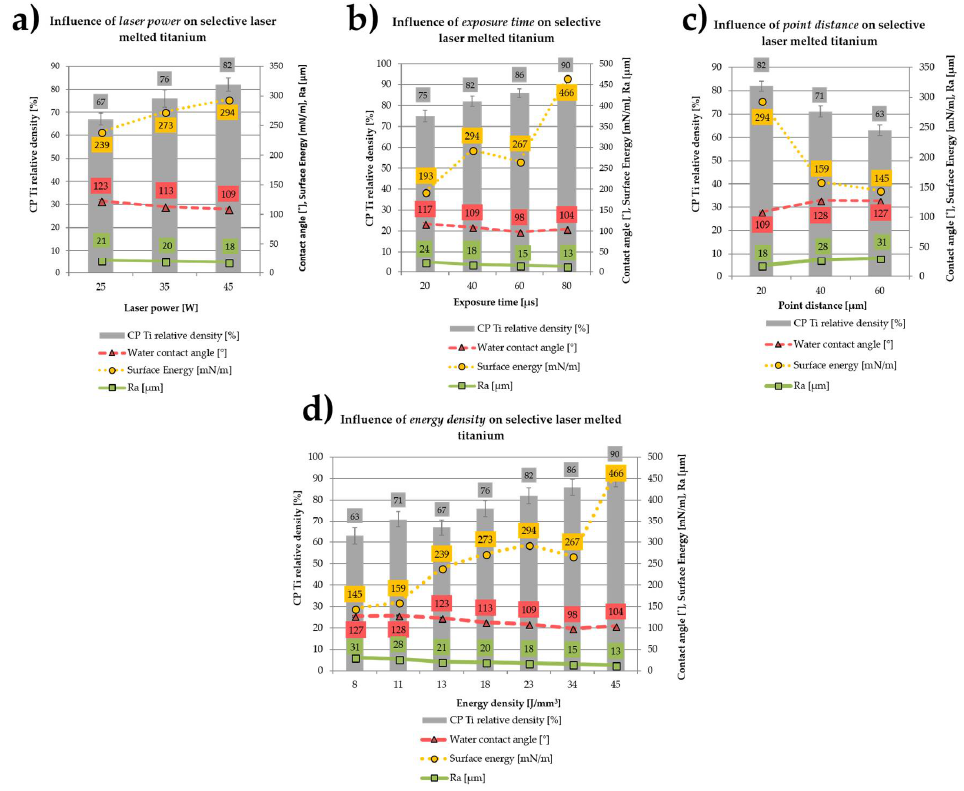
Figure 1. Influence of laser power ( a ), exposure time ( b ), point distance ( c ) and energy density ( d ) on the selective laser melted titanium relative density, surface energy, water contact angle and Ra parameter.